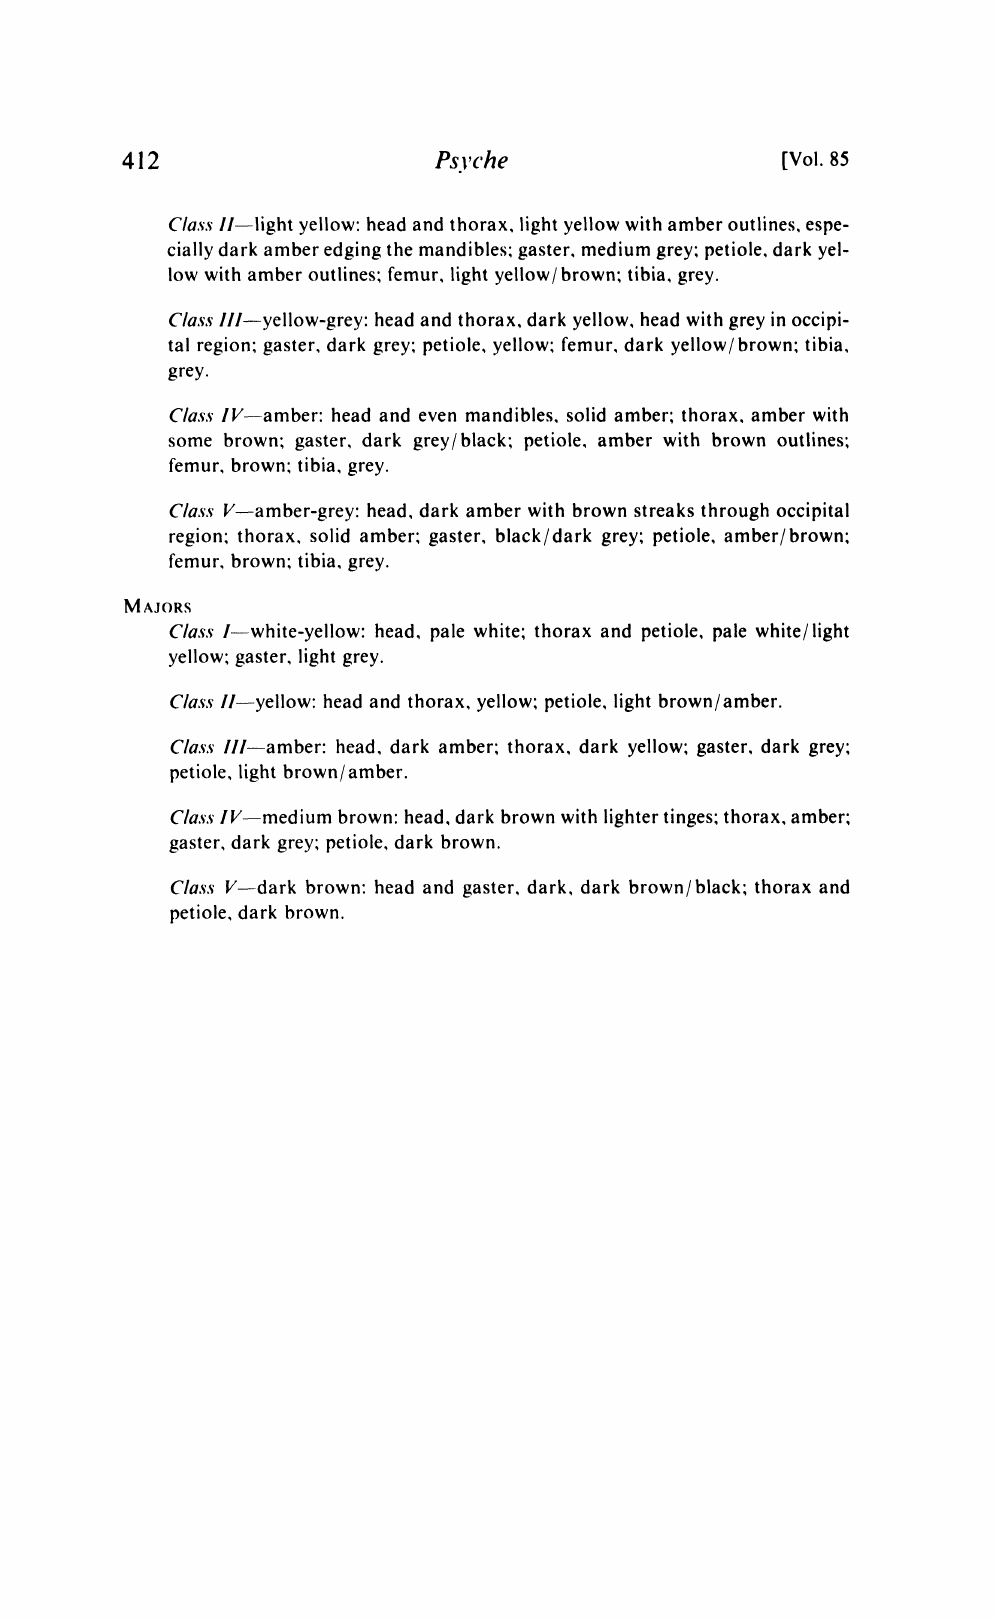
Class//--light yellow: head and thorax, light yellow with amber outlines, espe- cially dark amber edging the mandibles; gaster, medium grey; petiole, dark yel- low with amber outlines; femur, light yellow/brown; tibia, grey. Class Ill--yellow-grey: head and thorax, dark yellow, head with grey in occipi- tal region; gaster, dark grey; petiole, yellow; femur, dark yellow/brown; tibia, grey. Class IV--amber: head and even mandibles, solid amber; thorax, amber with some brown; gaster, dark grey/black; petiole, amber with brown outlines; femur, brown; tibia, grey. Class V--amber-grey: head, dark amber with brown streaks through occipital region; thorax, solid amber; gaster, black/dark grey; petiole, amber/brown; femur, brown; tibia, grey. MAJORS Class /--white-yellow: head, pale white; thorax and petiole, pale white/light yellow; gaster, light grey. Class//--yellow: head and thorax, yellow; petiole, light brown/amber. Class Ill--amber: head, dark amber; thorax, dark yellow; gaster, dark grey; petiole, light brown/amber. Class IV--medium brown: head, dark brown with lighter tinges; thorax, amber; gaster, dark grey; petiole, dark brown. Class V--dark brown: head and gaster, dark, dark brown/black; thorax and petiole, dark